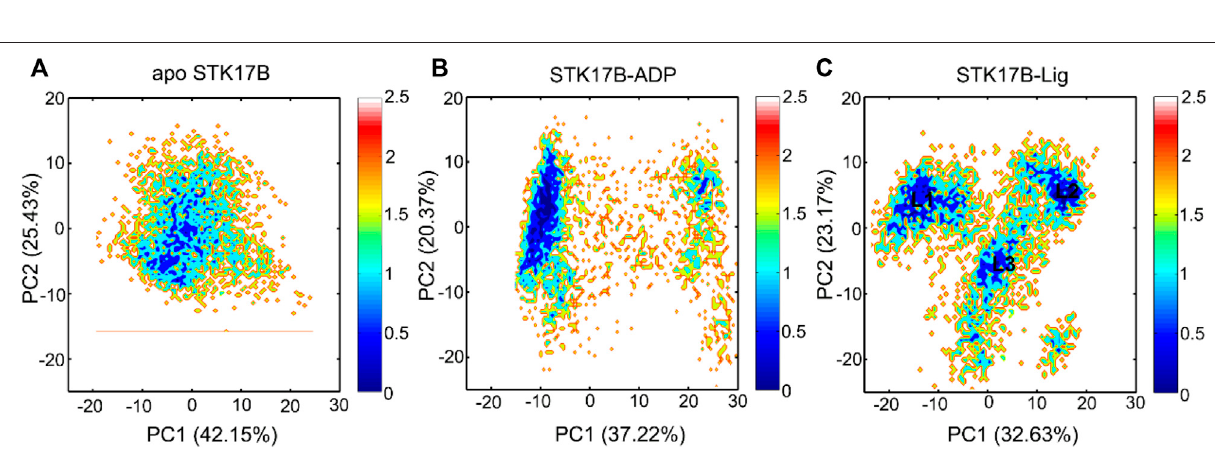
FIGURE 4 | The free energy landscape of the fi rst and second principal components (PC1 and PC2) for the apo (A) , ADP-bound (B) , and ligand-bound (C) systems. The unit of free-energy values is kcal/mol.